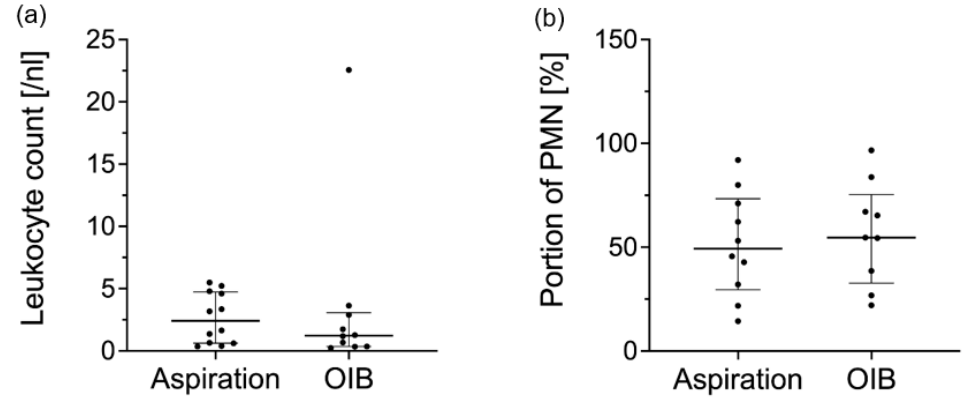
Figure 1. Laboratory results of synovial fluid aspiration in the outpatient setting and during OIB. ( a ) Leukocyte count and ( b ) proportion of PMN in the synovial fluid aspirations are displayed as scatter dot plot presenting medians and IQR. There were no significant differences between values assessed with outpatient and synovial fluid aspirations from OIB. This visualization solely displays patients with available outpatient and synovial fluid aspiration results from OIB ( a ) n = 10, ( b ) n = 9. Abbreviations: PMN: polymorphonuclear leukocytes; OIB: open incisional joint biopsy; IQR: Interquartile range.